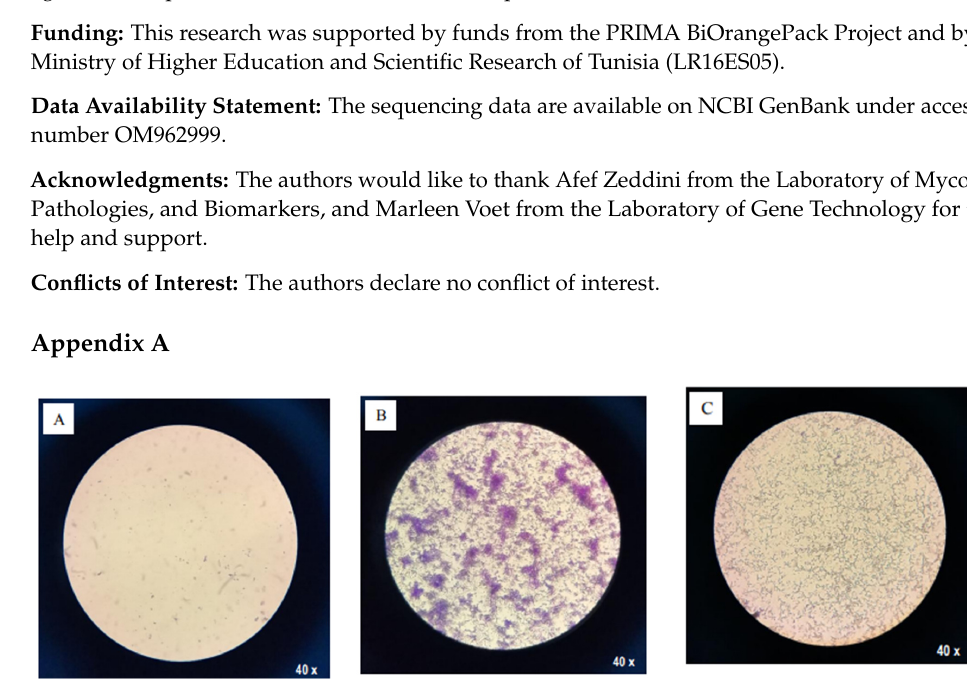
Figure A1. Phage anti-biofilm activity visualized using light microscopy (magnification 40×). ( A ) negative control; ( B ) positive control; ( C ) phage-treated sample. The bacterial biofilms are characterized by the formation of cell cluster structures stained in purple using crystal violet.